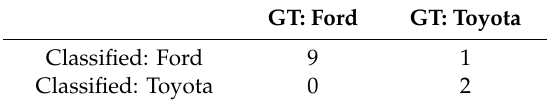
Table A4. Confusion matrix for the IMG430: 50% missing pixels trial with YOLO classification.